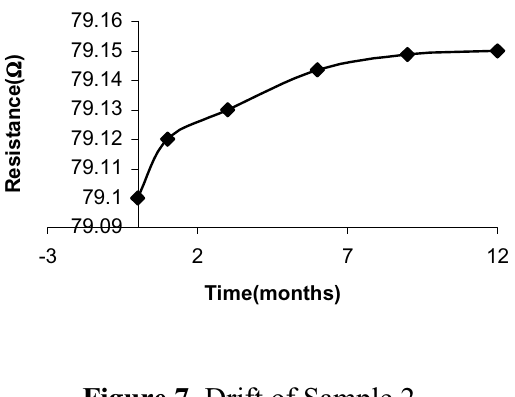
Figure 7. Drift of Sample 2.